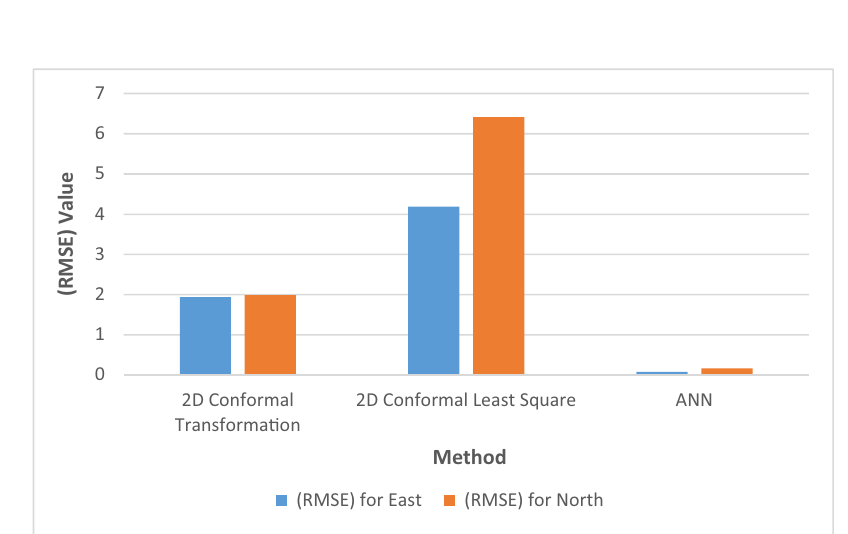
Figure 11: RMSE for the applied